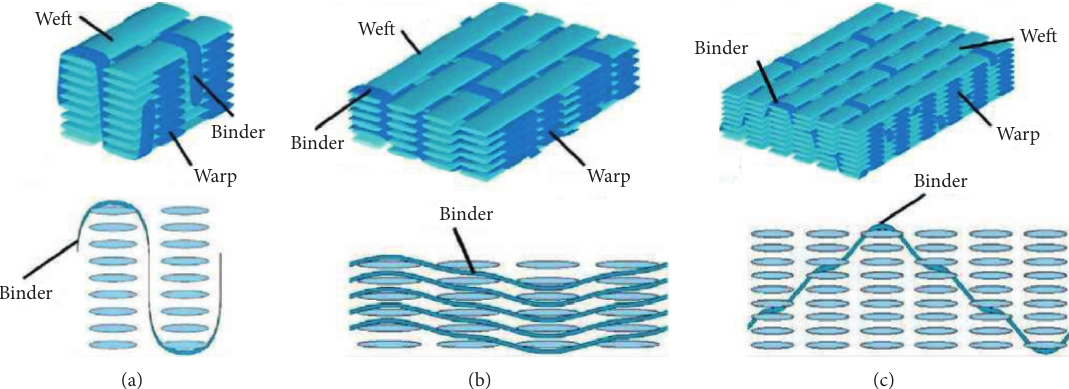
Figure 5: Types of 3D woven composites based on the binder path: ORT (a), LTL (b) and AI (c) [46]. Weft